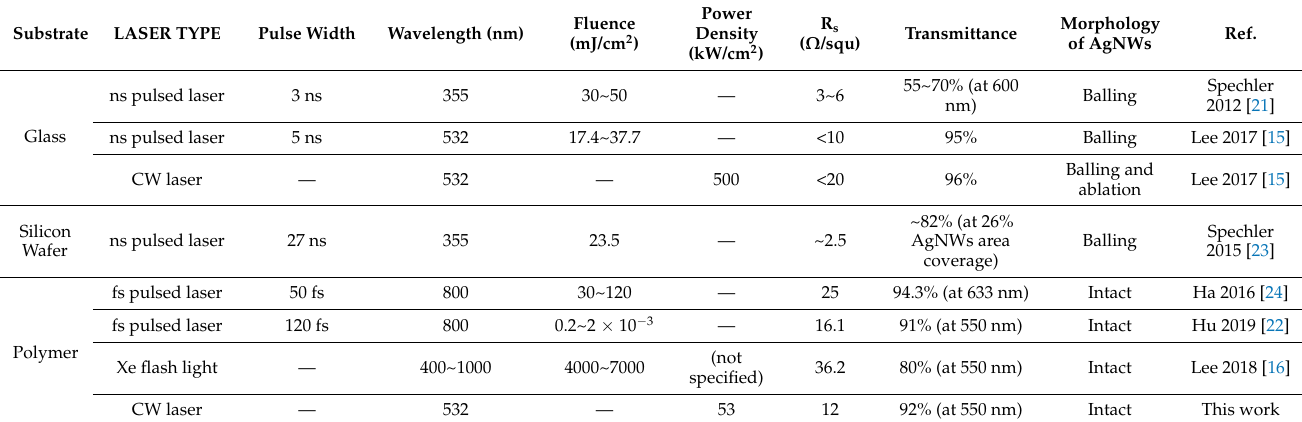
Table 1. Summary of laser nanowelding process of AgNWs.